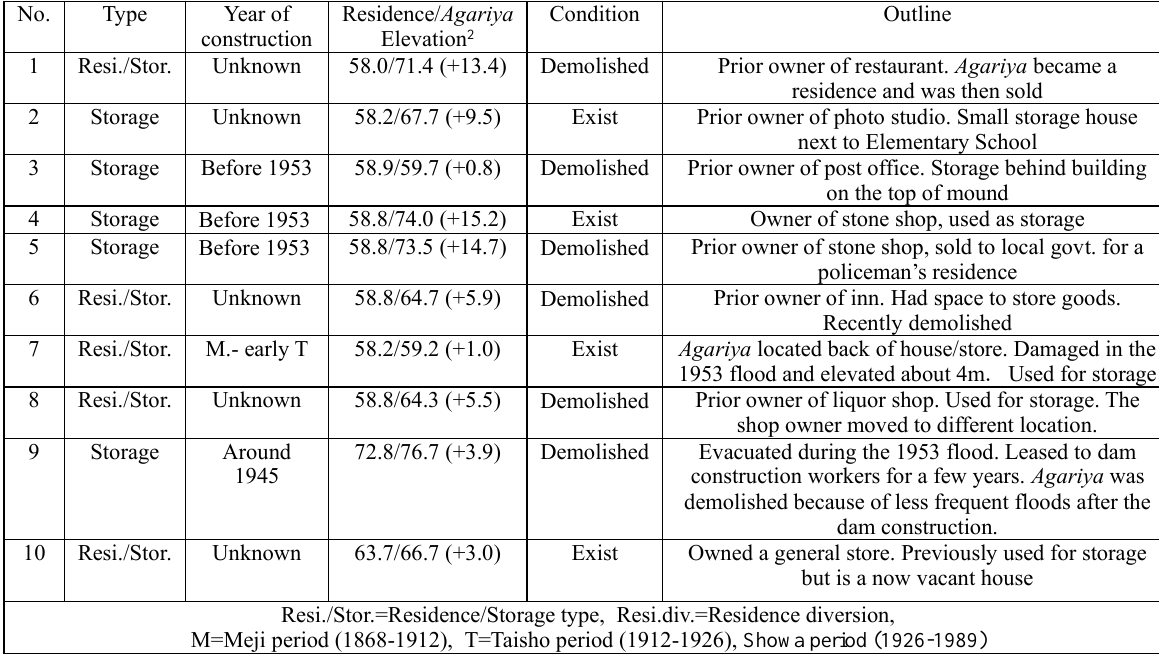
Table 2. Types, levels and current condition of Agariya in